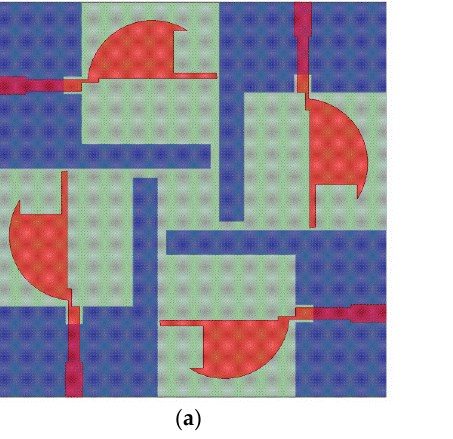
Figure 3. Surface current distribution at 6.5 GHz for ant3.